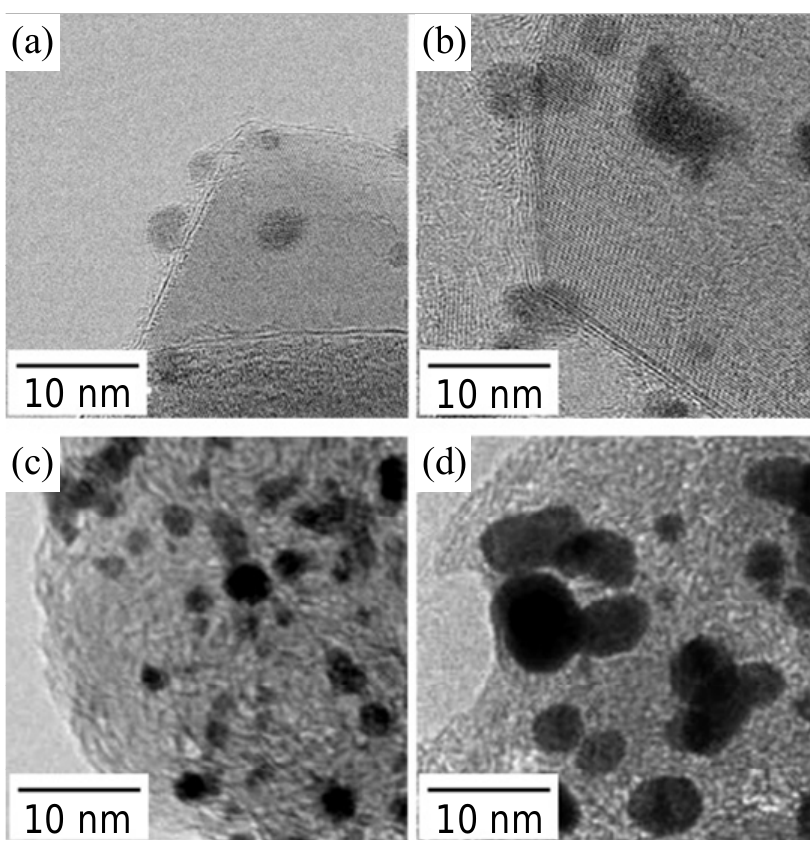
Figure 9. TEM images of Pt/TiC-600 °C ( a ) ( b ) and c-Pt/CB ( c ) ( d ) before ( a ) ( c ) and after ( b ) ( d ) the durability test ( N =